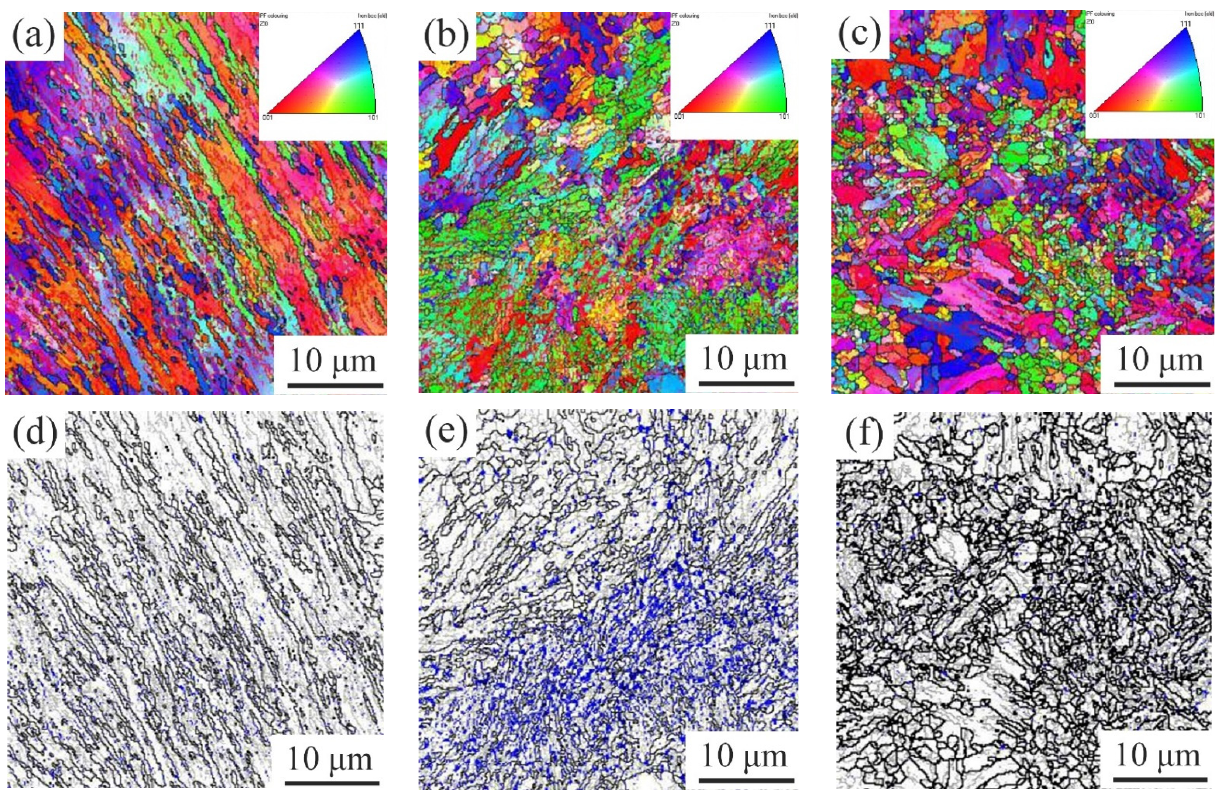
Figure 7. EBSD analysis of RA: ( a , d ) 600 °C; ( b , e ) 620 °C; ( c , f ) 650 °C.